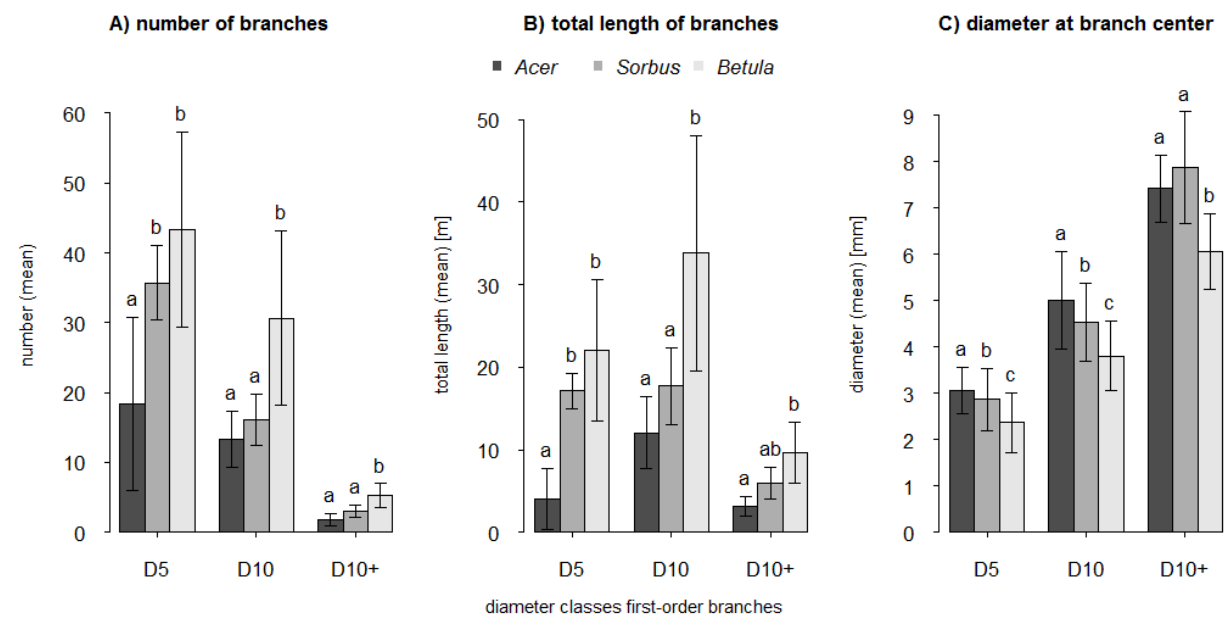
Figure 4 . Barplots of mean values (and SD) of the structural complexity variables ( A ) branch number, ( B ) total length of branches and ( C ) diameter at branch center for first-order branches and diameter classes: D5 ≤ 5 mm, 5 mm < D10 ≤ 10 mm, D10+ > 10 mm. Different lower case letters indicate significant differences between tree species in post hoc Tukey tests ( p < 0.05).